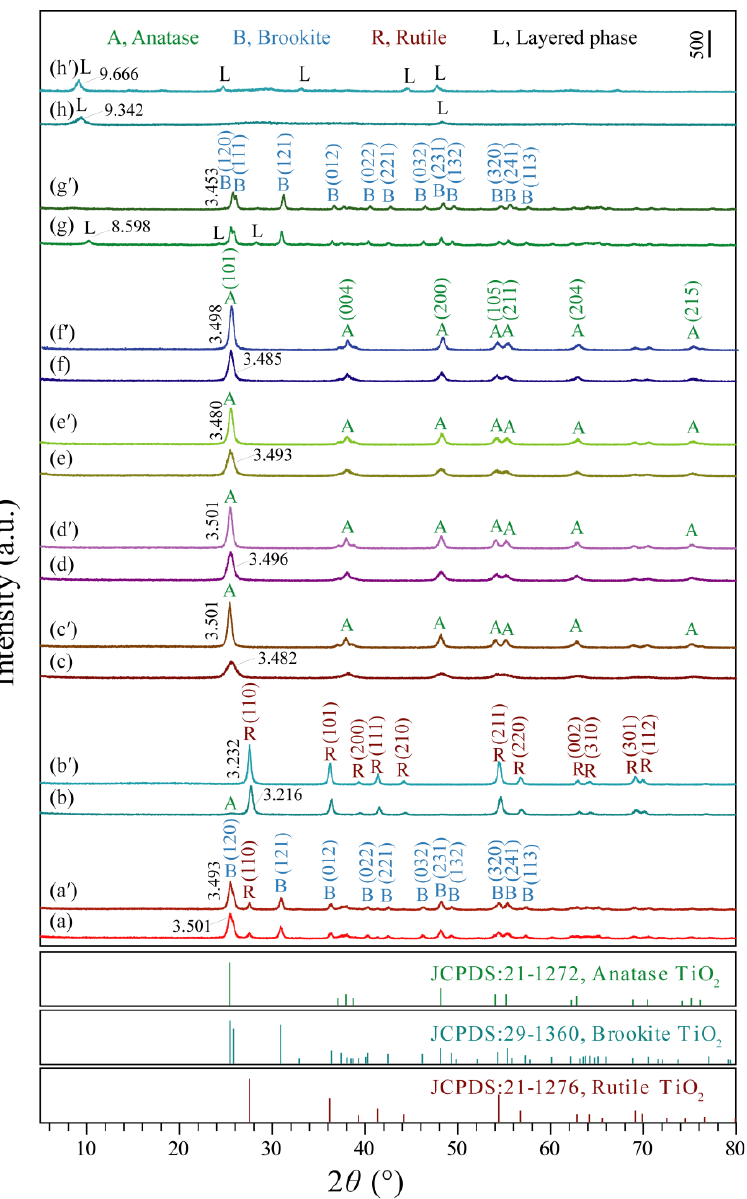
right, which is due to the slight reduction of the interplanar spacing of the as-synthesized brookite TiO 2 ( d (120) = 3.453 Å). Compared with Figure 1g, the layered phase disappeared, indicating that the decomposition of H 2 Ti 4 O 9 · H 2 O occurred at high temperature. As can be seen from Figure 1h (cid:48) , the pH12.5-T500-TiO 2 product obtained after high-temperature calcination is still a layered phase. Compared with Figure 1h, the basic layer spacing of the (200) crystal plane increases from 9.342 to 9.666 Å, resulting in the diffraction peak slightly shifting to the left. In addition, the intensity of the diffraction peaks is significantly enhanced, indicating an increase in crystallinity.